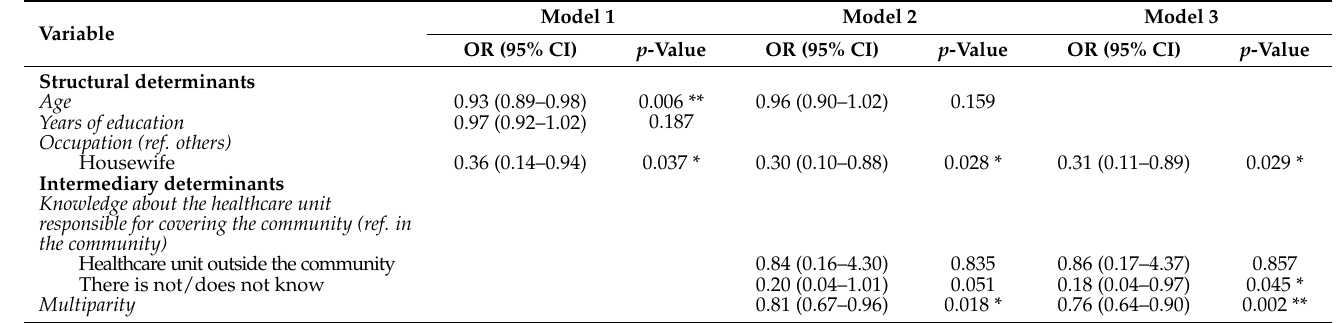
Table 3. Adjusted odds ratios for performing cervical screening in the past three years in women aged 25 to 59